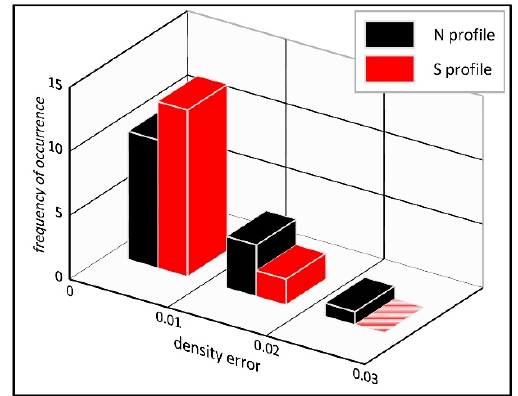
Figure 7. Frequency of density error occurrence.